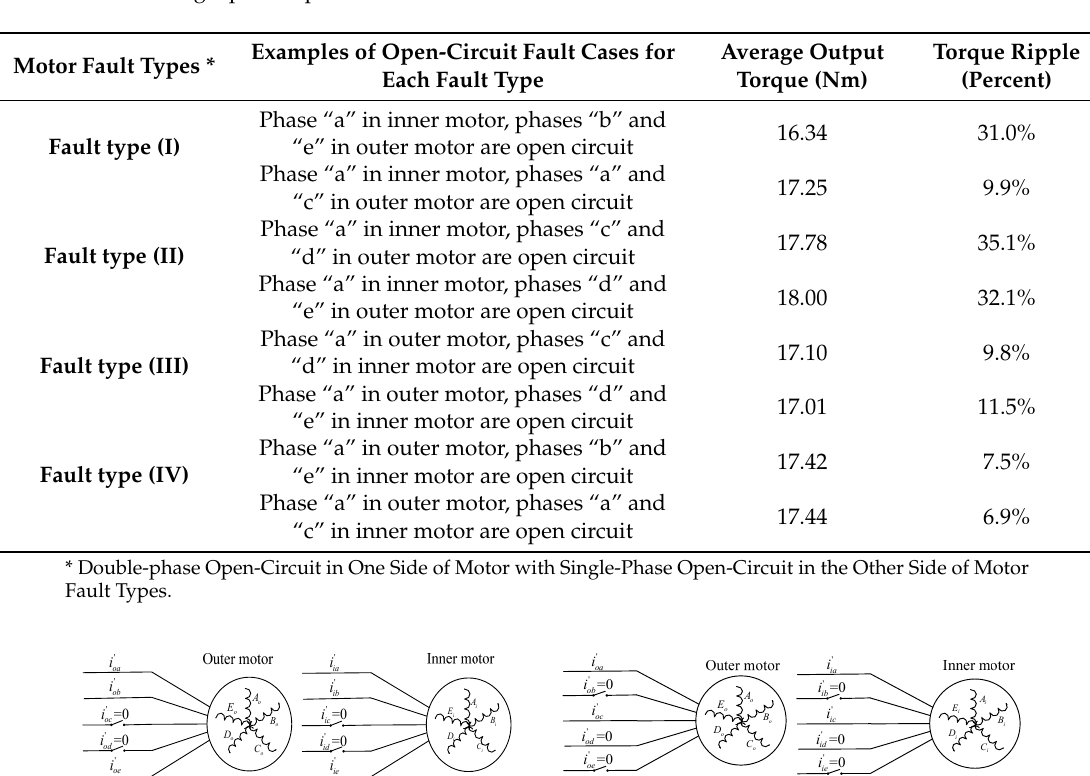
Table 12. The details of electromagnetic torque under double phase open circuit fault in one side of motor with single phase open circuit in another side of the motor.